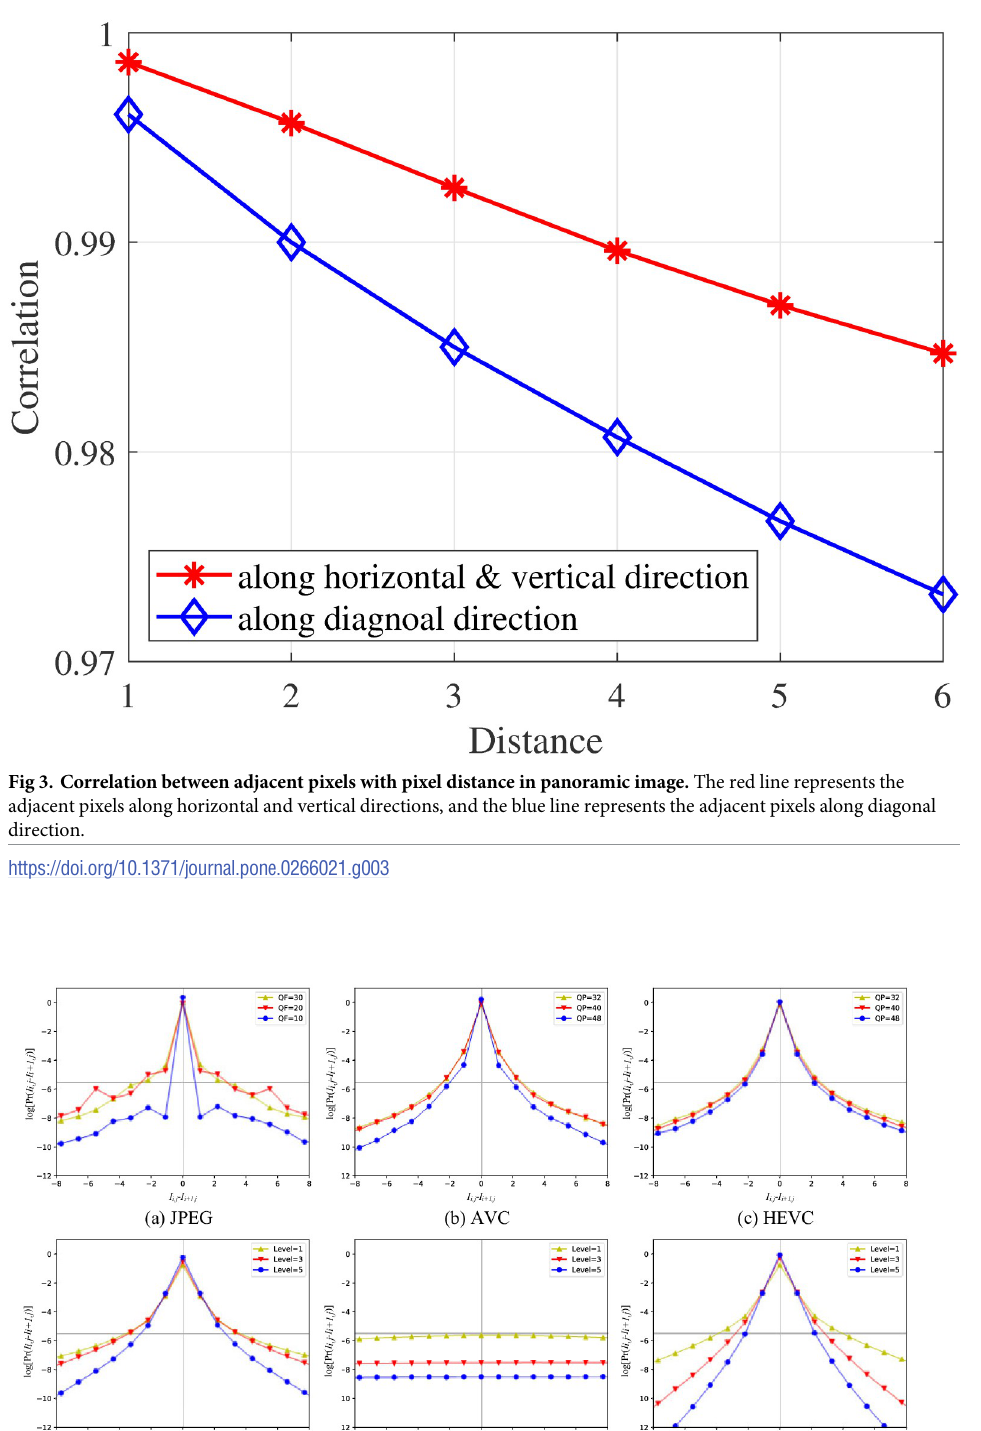
PLOS ONE | https://doi.org/10.1371/journal.pone.0266021 March 28,